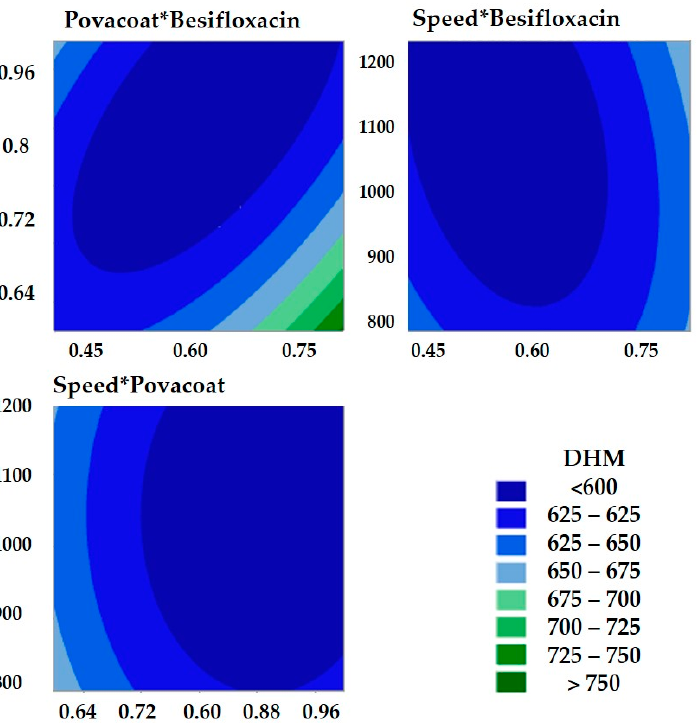
Figure 3. Contour graph related to the Z-ave evaluation of the besifloxacin nanocrystal, whose variables are besifloxacin concentration (wt%), Povacoat ® concentration (wt%), and velocity (rpm). The regression equation obtained for the mathematical model of the experiment is described in Equation (1).